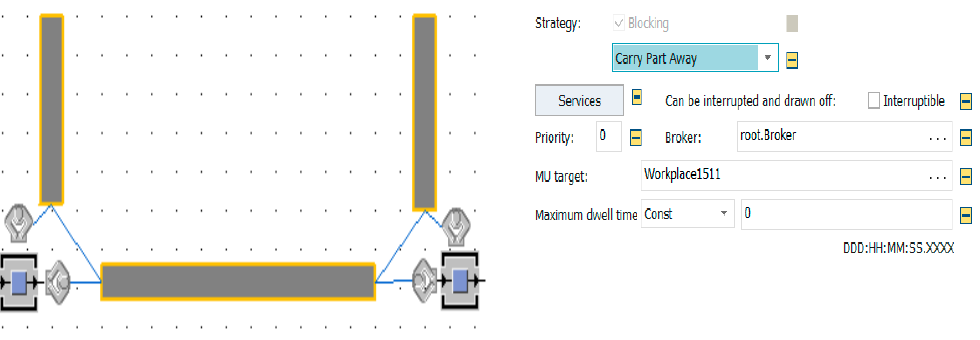
Electronics 2020 , 9 , x FOR PEER REVIEW